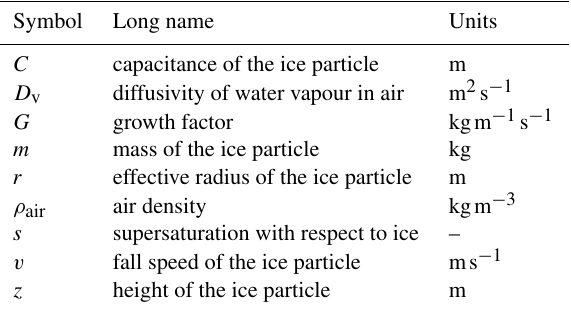
Table 1. Variables used in the sublimation calculations as described in the text. For a comprehensive list, see also Table